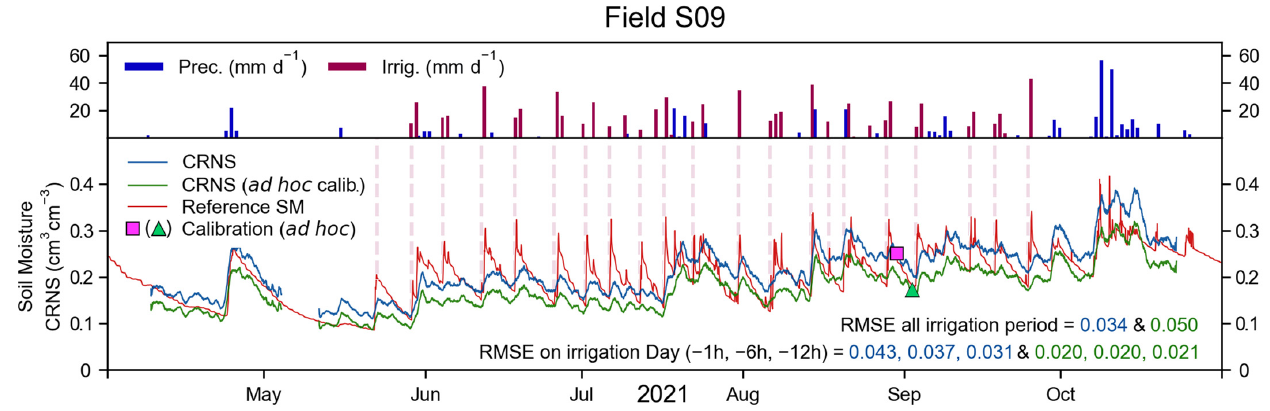
Figure 5. For field S09, during the 2021 irrigation period: precipitation, irrigation, reference SM and CRNS-derived SM obtained with a standard calibration procedure (blue line and pink square) and with an ad hoc calibration procedure (green line and triangle). The RMSE of the entire irrigation period and at one, six, and twelve hours before irrigation is shown in the bottom panel. Irrigation dates selected for the RMSE calculation are marked with red, vertical, dashed lines. Regressions of these measurements are provided in Appendix C.